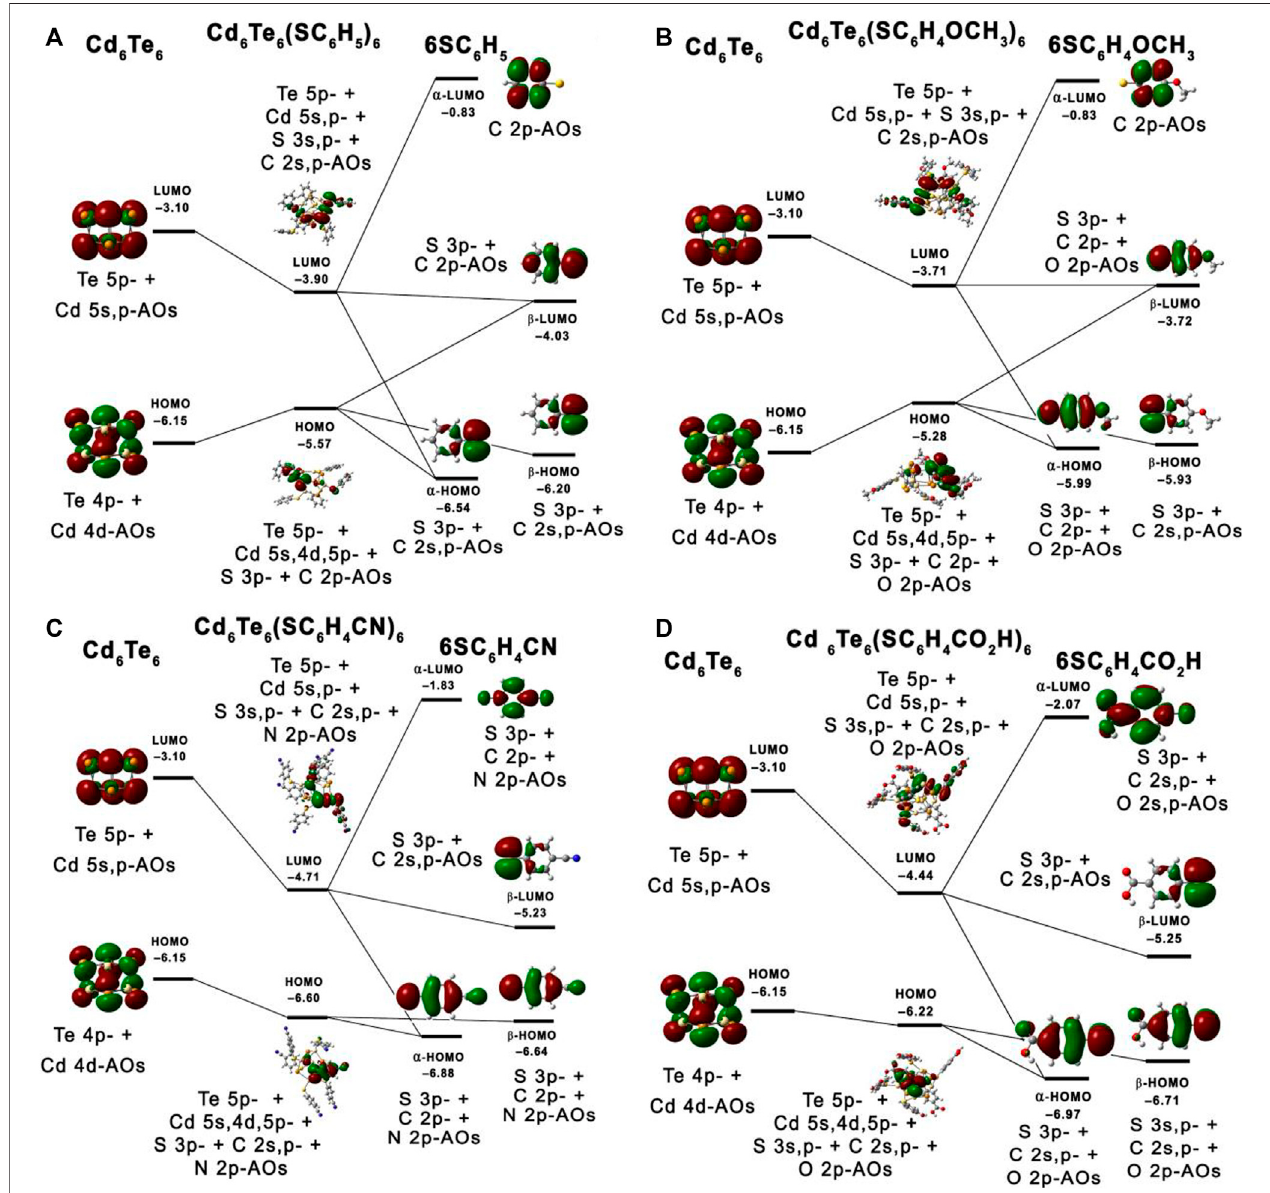
FIGURE6| OrbitalmixingdiagramdepictinginteractionsbetweenHOMOsandLUMOsofthecappedCd 6 Te 6 (TP) 6 (A) ,Cd 6 Te 6 (MBT) 6 (B) ,Cd 6 Te 6 (MBN) 6 (C) and Cd 6 Te 6 (MBA) 6 (D)